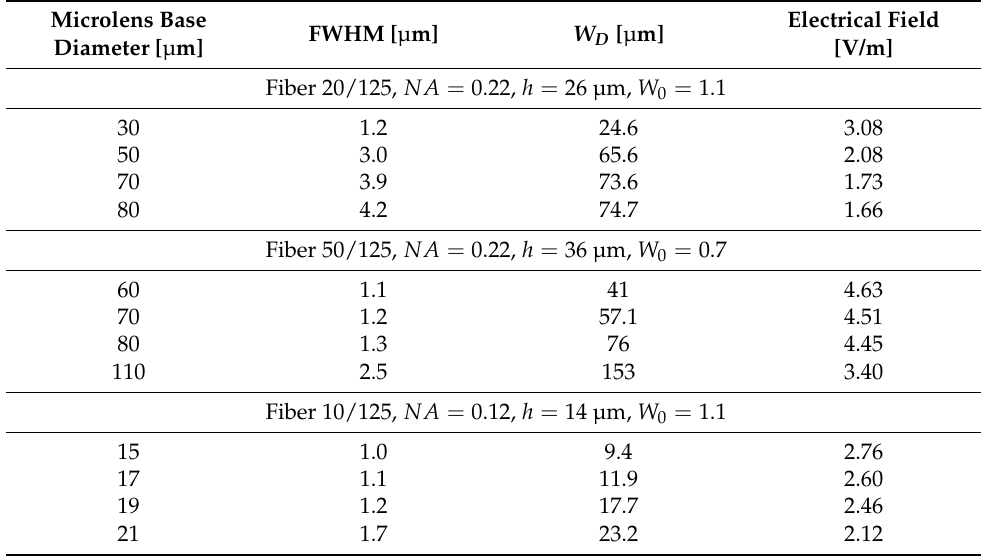
Table 1. Focus parameters for several fibers and lens diameters D , λ = 1064 nm. Unitary fundamental mode